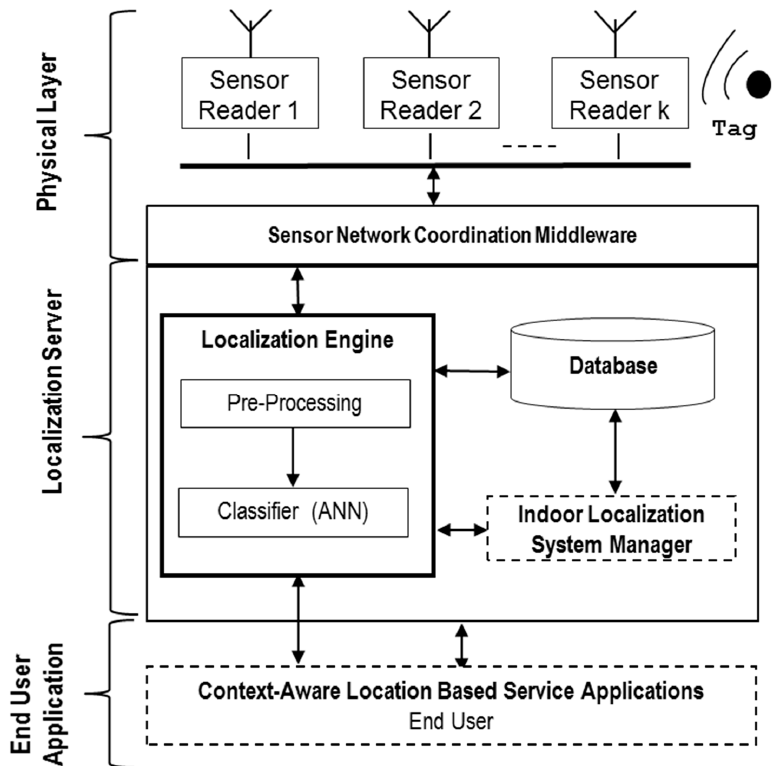
Figure 1. Block diagram of the proposed RSS-based indoor localization system (ILS).